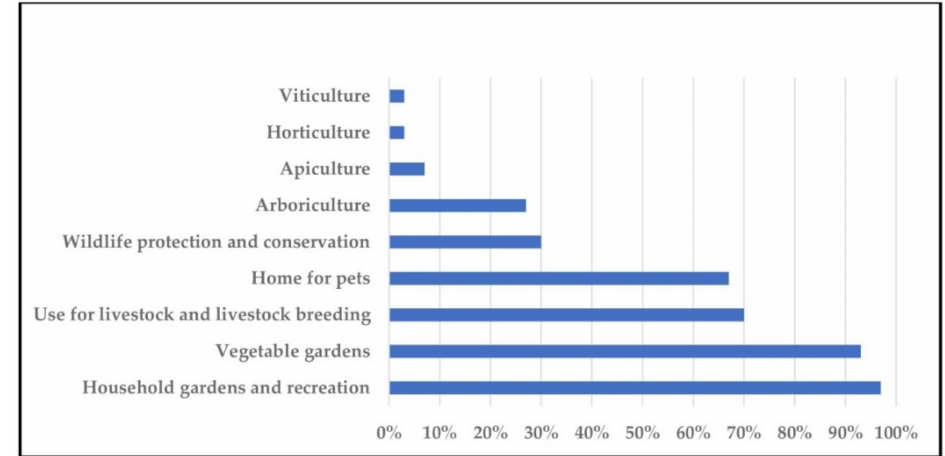
Figure 3. Percentage of properties engaging in different land use activities. Native trees were the most common natural feature on properties, with 70% of respondents’ properties containing native trees and 53% of respondents having native shrubs/grassland on their property. Natural ponds/wetlands were present on 20% of properties, with streams present on 27% of properties and 13% of respondents having access to